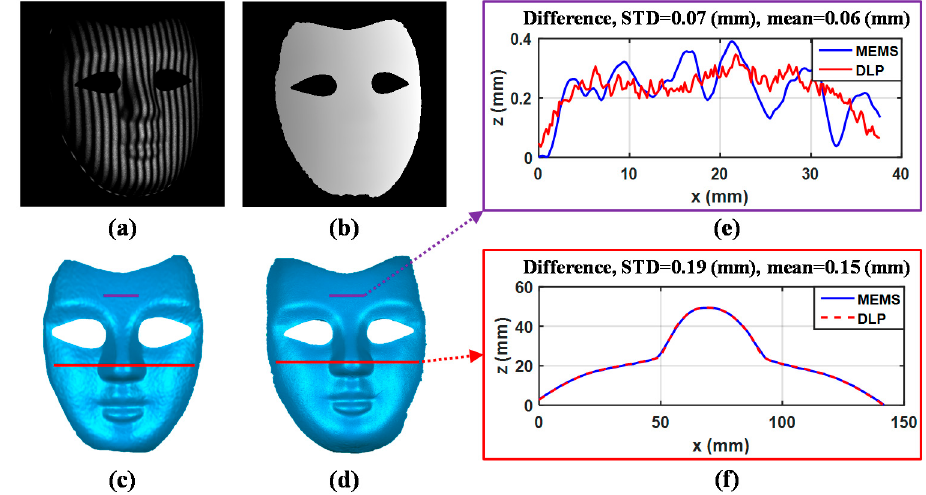
Figure 8. The measurement results of a face mask. ( a ) One of the captured fringe images; ( b ) Unwrapped phase map by using the projector of MEMS; ( c ) Reconstructed 3D geometry using phase map shown in ( b ); ( d ) Reconstructed 3D geometry by using the projector of DLP; ( e ) 3D data comparison in a cross-section between MEMS projection and DLP projection, the cross-section on the forehead with purple line as shown in (c) and (d); ( f ) 3D data comparison in a cross-section between MEMS projection and DLP projection, the cross-section on the middle face with red line as shown in (c) and (d).